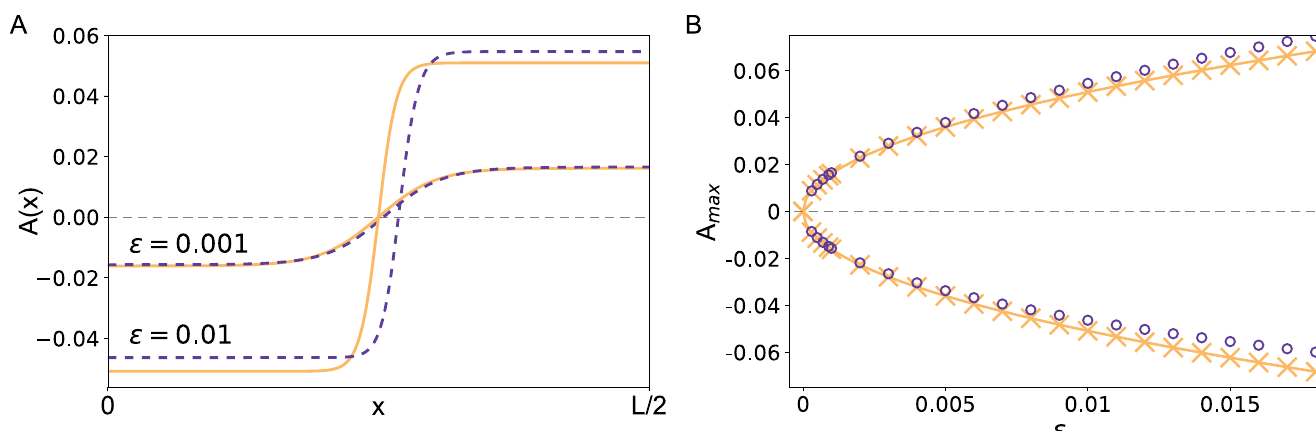
Fig 2. Comparison of steady state solutions of the polarization model and its corresponding CH model in the symmetric case. (A) Steady state profiles for a 2 = 2 and two values of ε = 0.001 and ε = 0.01 for the polarization model in Eqs (1) and (2) with A ð x Þ ¼ ð v model in Eq (30) (solid lines). (B) Plateau values of the steady state profiles shown in (A) as function of ε for the basic polarization model (circles) and the CH model (crosses). The solid line shows an analytical approximation for the plateau values in the CH model given by Eq (37).